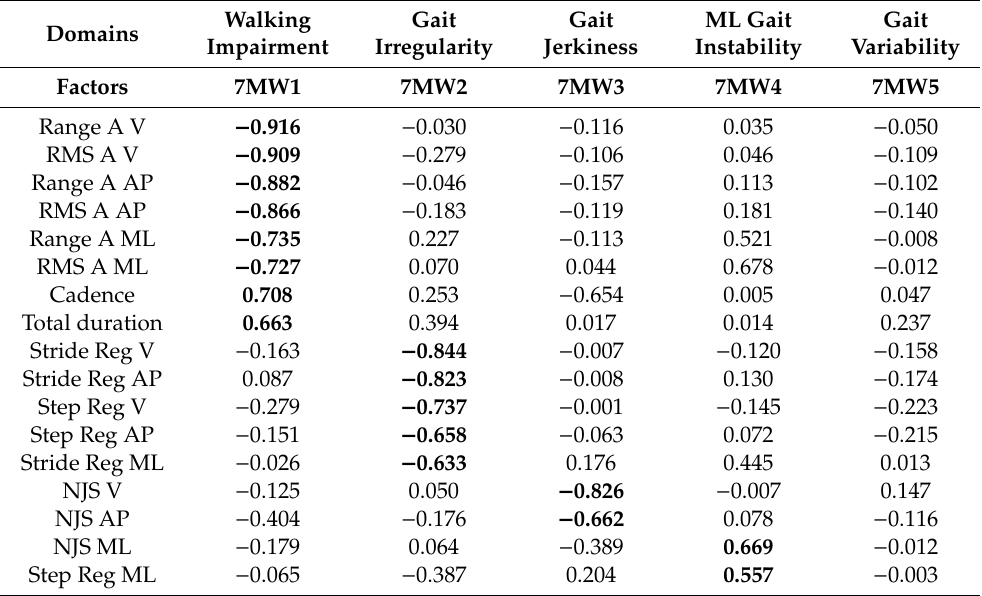
Table 6. 7MWT factor model: Factor loadings of the sensor-based measures, corresponding domains and Cumulative Variance (CV) (Varimax